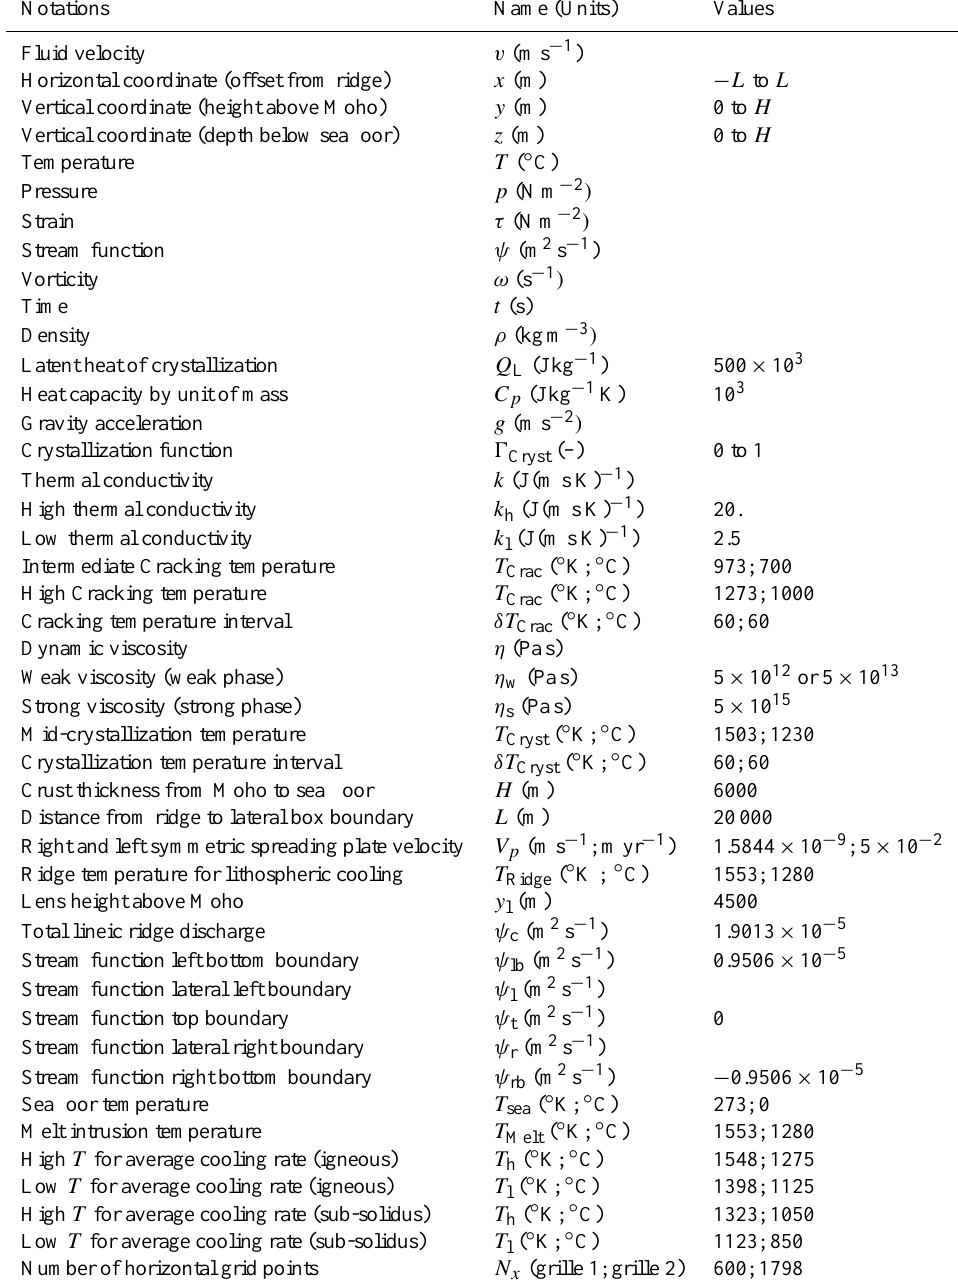
Table 1. Notations and values used in this